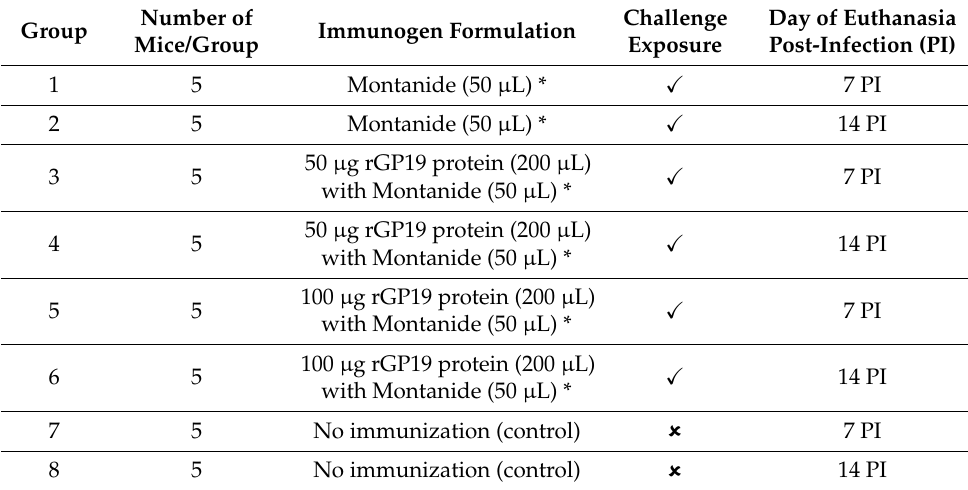
Table 1. Immunization and Ehrlichia canis challenge experiments in mice. Number of Group